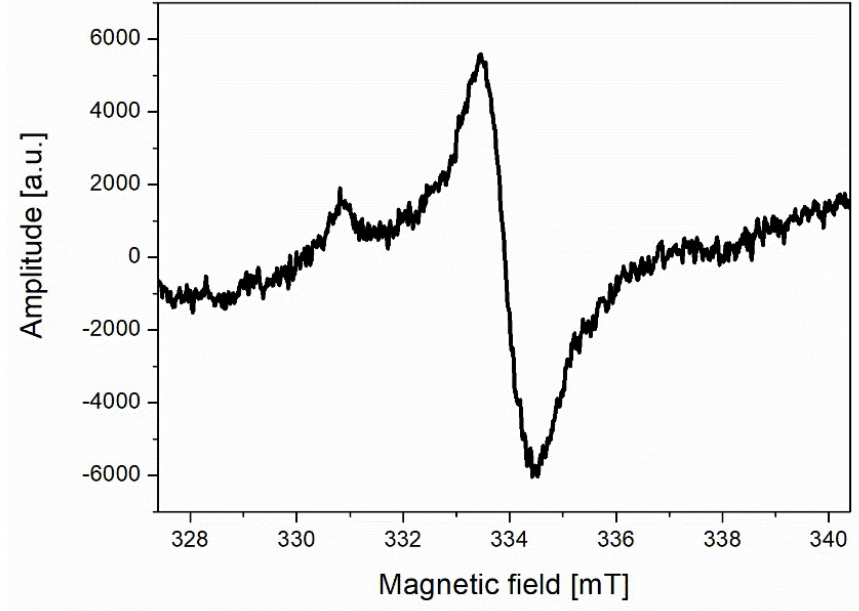
Figure 14. ESR spectrum (240 K) of TEMPO spin probe measured after 2 h of incubation with HL-60 leukemia cells.